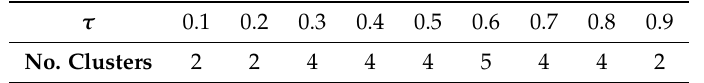
Table 6. Sensitivity of parameter τ while l = 3 and β = 0.5 to evaluating the number of clusters that can be automatically generated by HESSC.